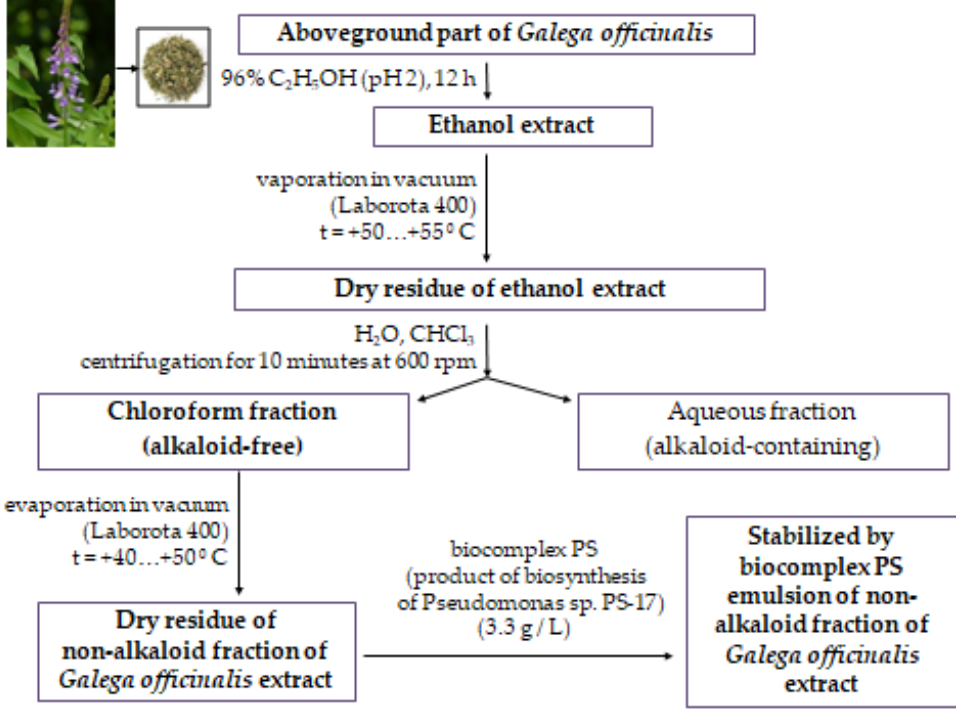
Figure 1. Scheme of obtaining a non-alkaloid fraction of Galega officinalis extract. The presented method of extraction and stabilization of obtained chloroform fraction allows obtaining a stable water emulsion deprived of poisonous